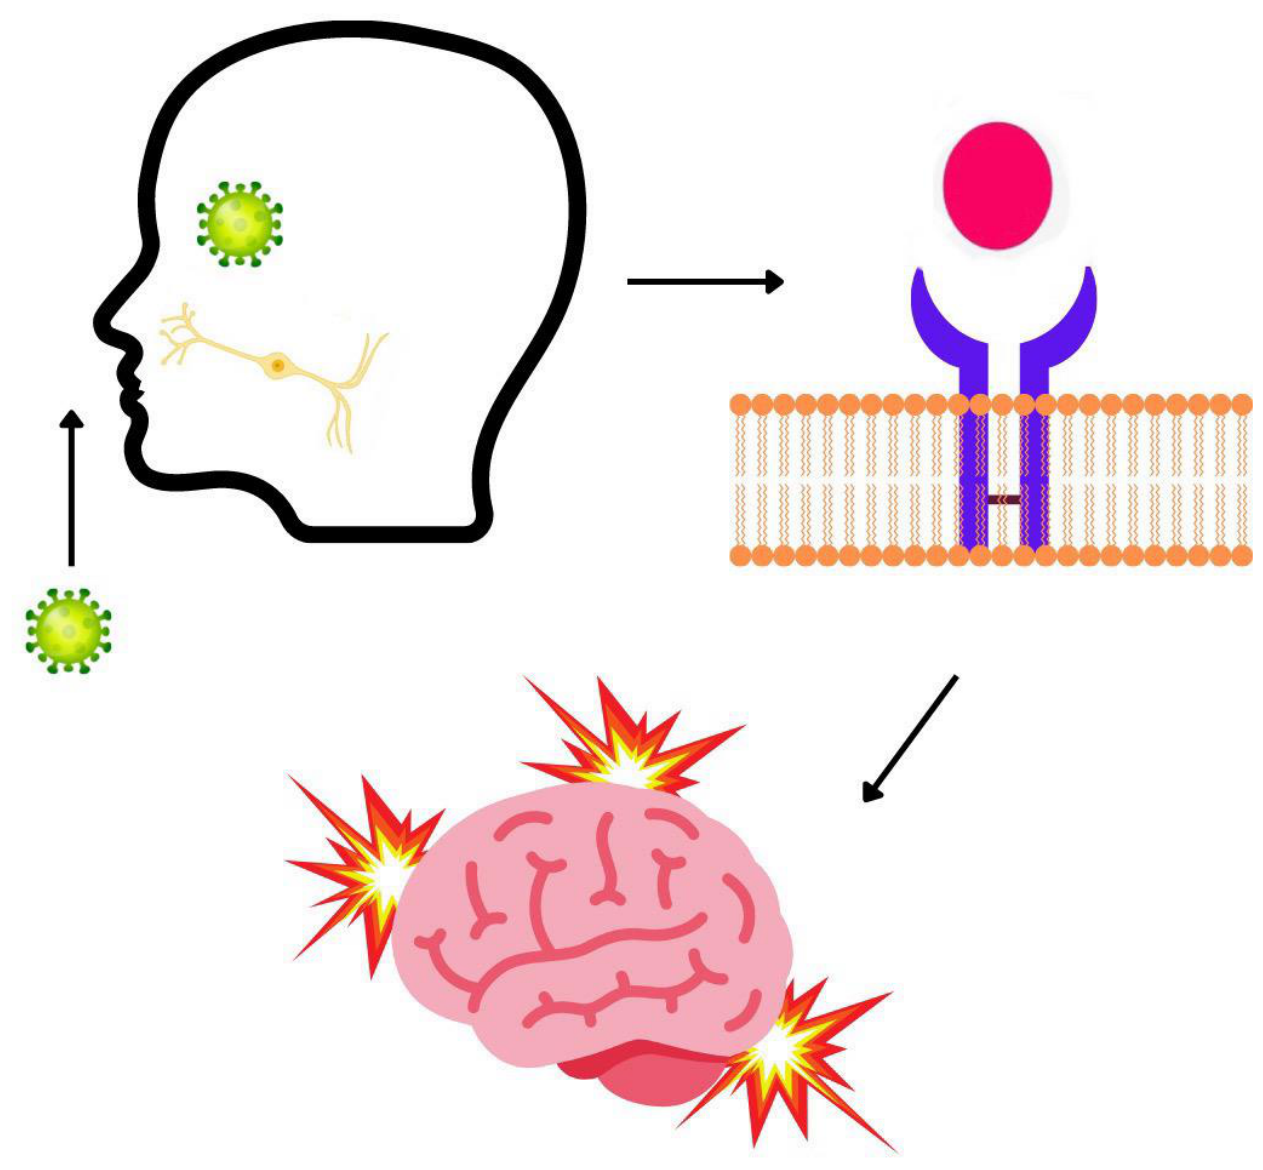
Figure 1. Entry of the COVID-19 virus happens retrograde through the olfactory nerve. Viral S proteins then bind to the ACE2 receptor on glial cells, which causes neuroinflammation.